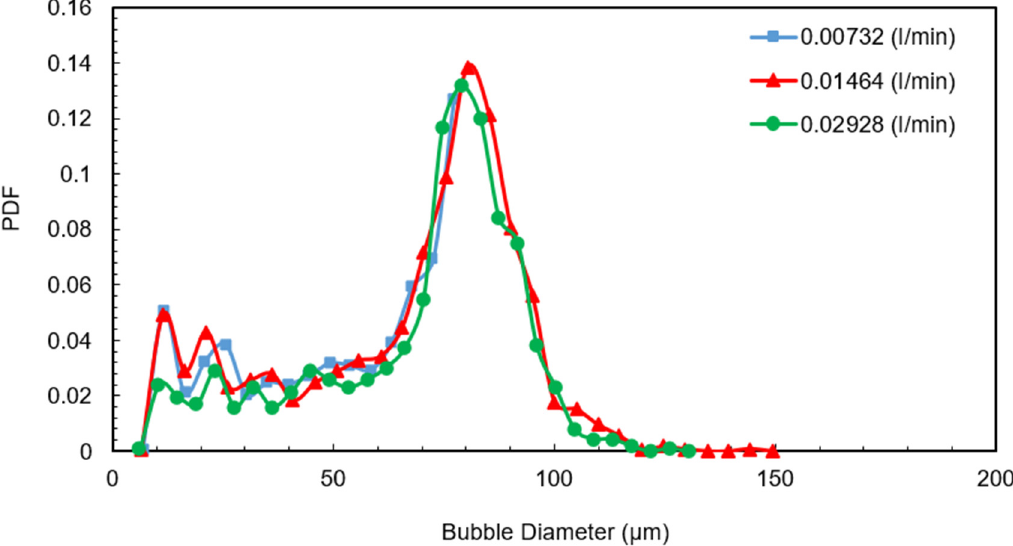
Figure 8. Distribution of bubble diameters at different air volume flow rate (water flow rate = 1.22 L/min) (CFD only). Average diameter: 0.05 L/min ‐ 63.6 μ m (CFD), 0.1 L/min ‐ 64.1 μ m (CFD), 0.2 L/min ‐ 66.9 μ m (CFD). (Throat Reynolds num ‐ ber (Re) = 9250).